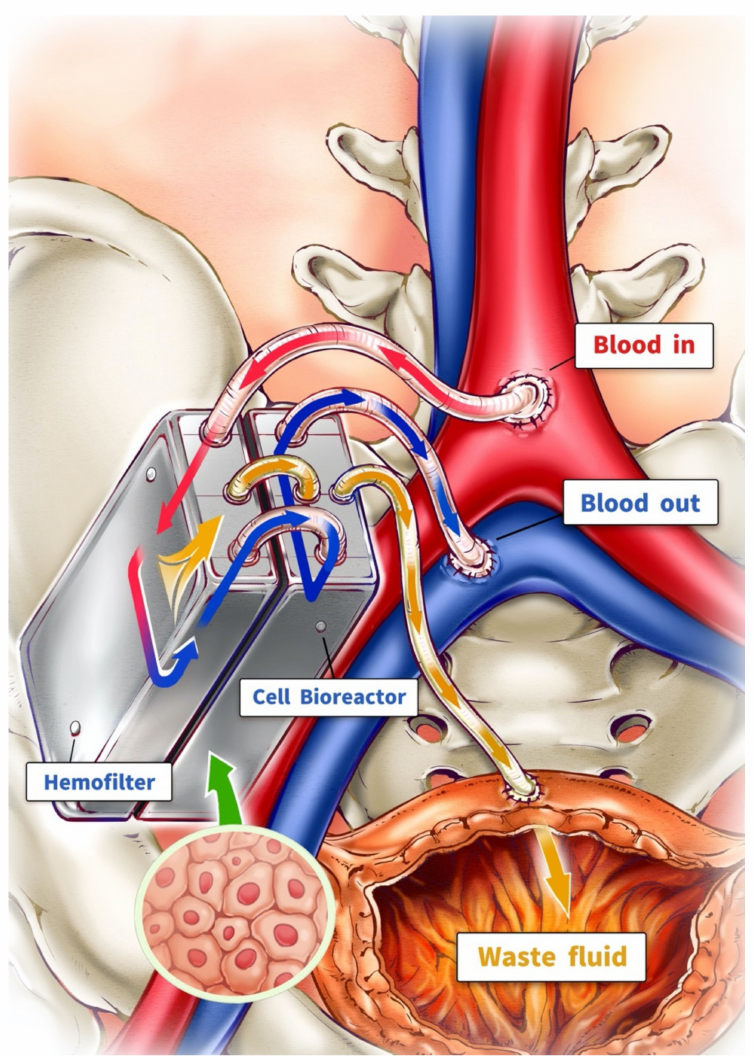
Figure 4. Implantable kidney: driven by the pressure difference in the artery and vein, blood passes through the implantable kidney, which is composed of a hemofilter and cell bioreactor. With a nanopore silicon membrane, waste fluid (yellow) created by hemofiltration flows into the patient’s urinary bladder. Dialyzed blood is transferred to the cell bioreactor after hemofiltration. Natural kidney metabolic function is restored by protected renal tubule cells in the cell